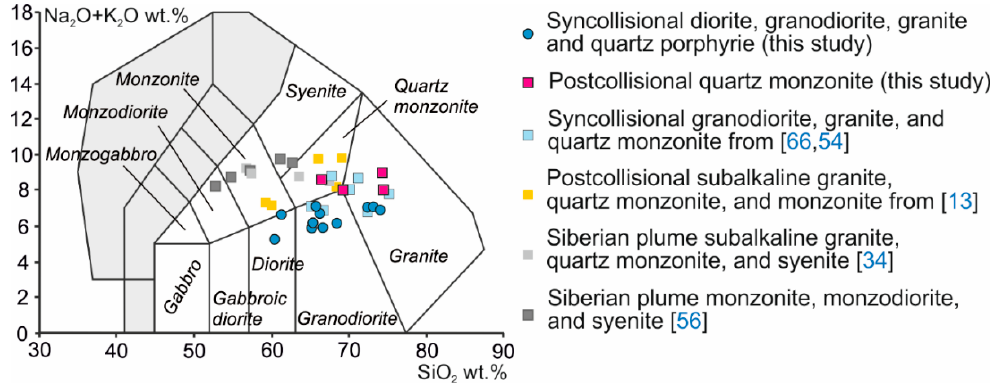
Figure 9. TAS diagram from [97] for the studied felsic rocks.